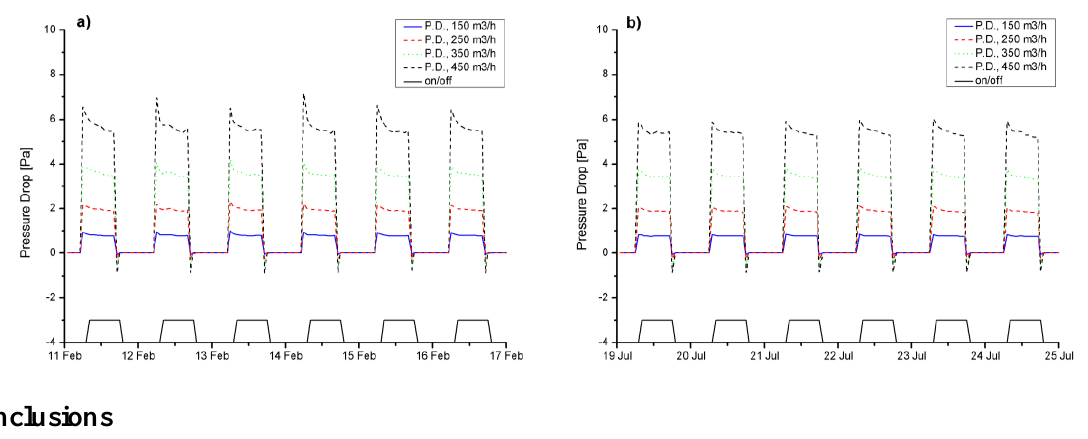
Figure 16. Pressure drops of air vs. time varying the air mass flow rate for typical: ( a ) winter week and ( b ) summer